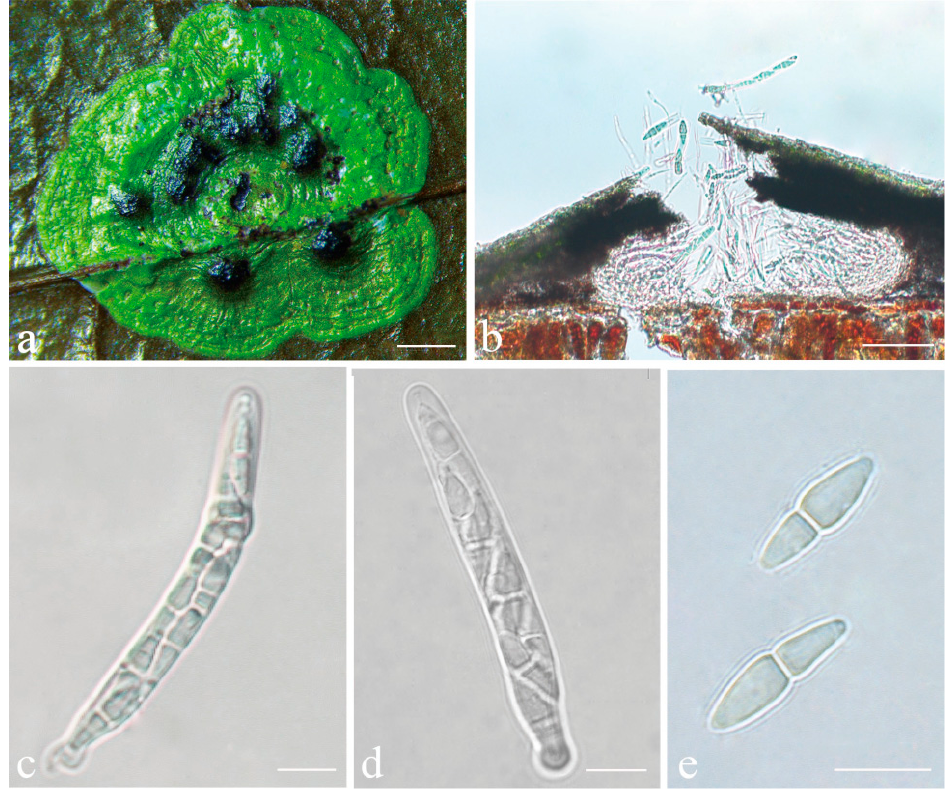
Figure 9. Strigula laevis sp. nov. (holotype, HMAS–L0141592). ( a ) Thallus; ( b ) perithecia; ( c , d ) asci; ( e ) ascospores. Scale bars: ( a ) = 500 μ m, ( b ) = 50 μ m, ( c ) = 20 μ m, ( d , e ) = 10 μ m. Strigula microcarpa S.H. Jiang, J.C. Wei & Lücking, sp. nov. (Figure 10). MycoBank MB 838165.